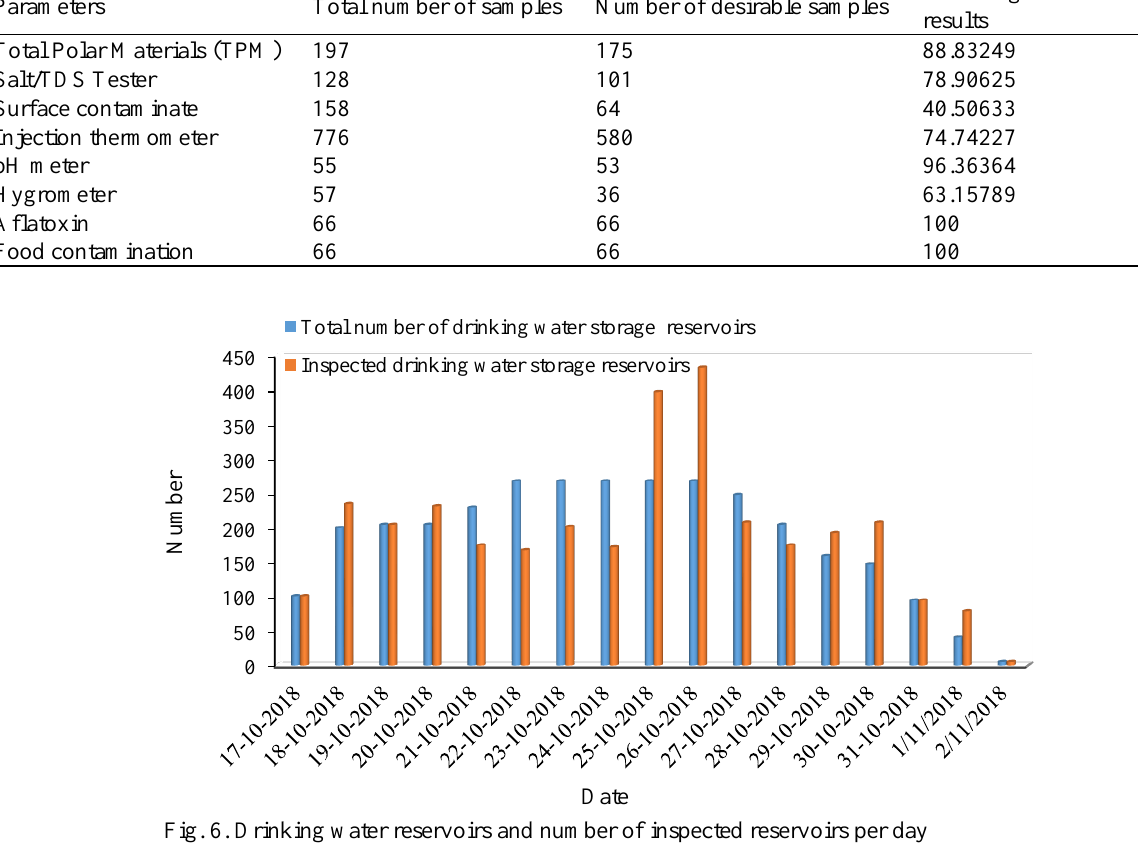
Table 2. Tests implemented on food products, number of samples, and percentage of desirable samples Parameters Total number of samples